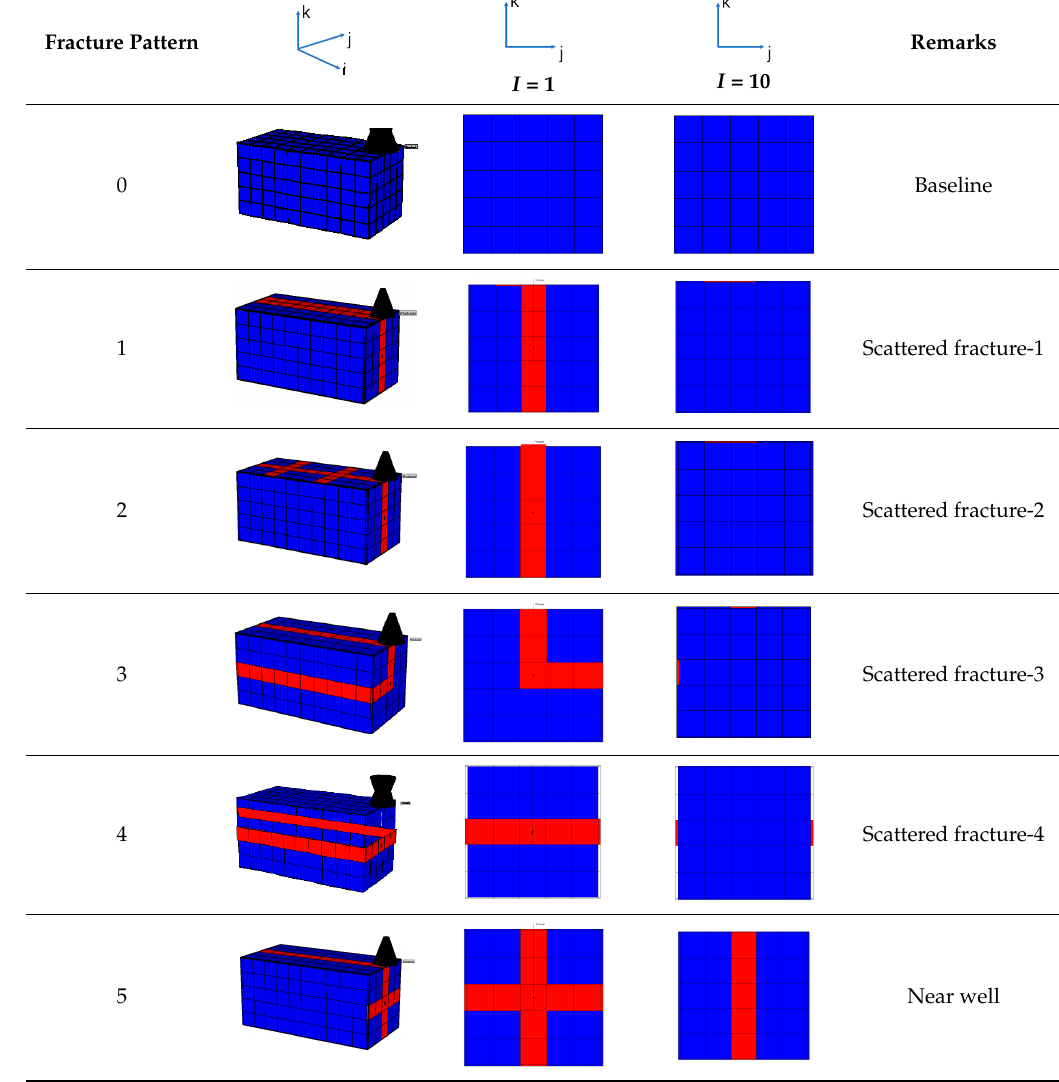
Table 6. Settings of fracture contact relationships.